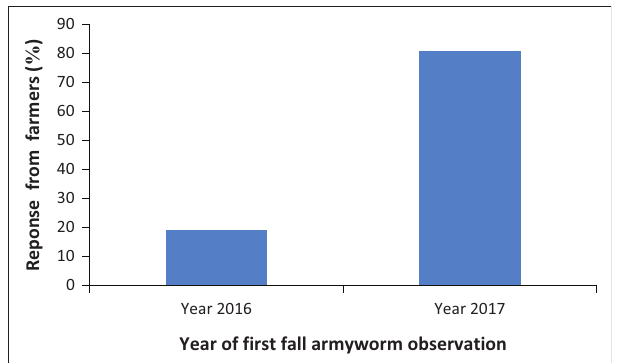
FIGURE 2: Farmers response on the years for first fall armyworm